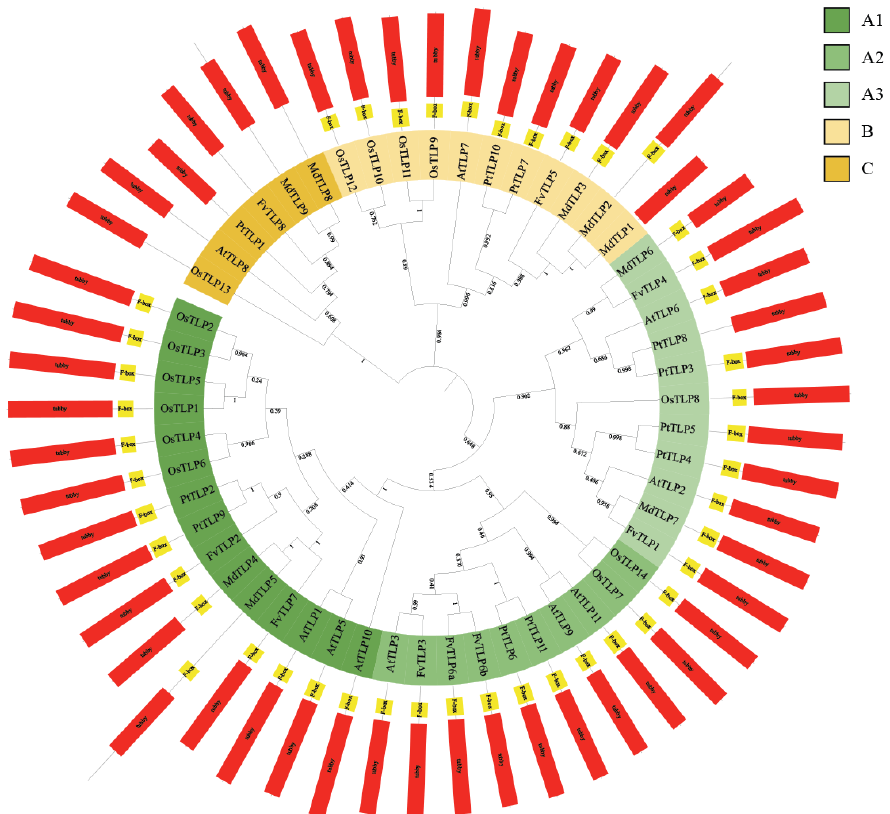
Figure 1. Phylogenetic tree and conserved domains of TLPs. The phylogenetic tree was constructed using the maximum likelihood method based on multiple sequence alignments of TLP proteins from Arabidopsis thaliana , Oryza sativa , Malus domestica , Populus trichocarpa , and Fragaria vesca . The tree was divided into three phylogenetic subfamilies, which are shown in different colors. Positions of the conserved F ‐ box (yellow rectangle) and tubby (red rectangle) domains are also shown.